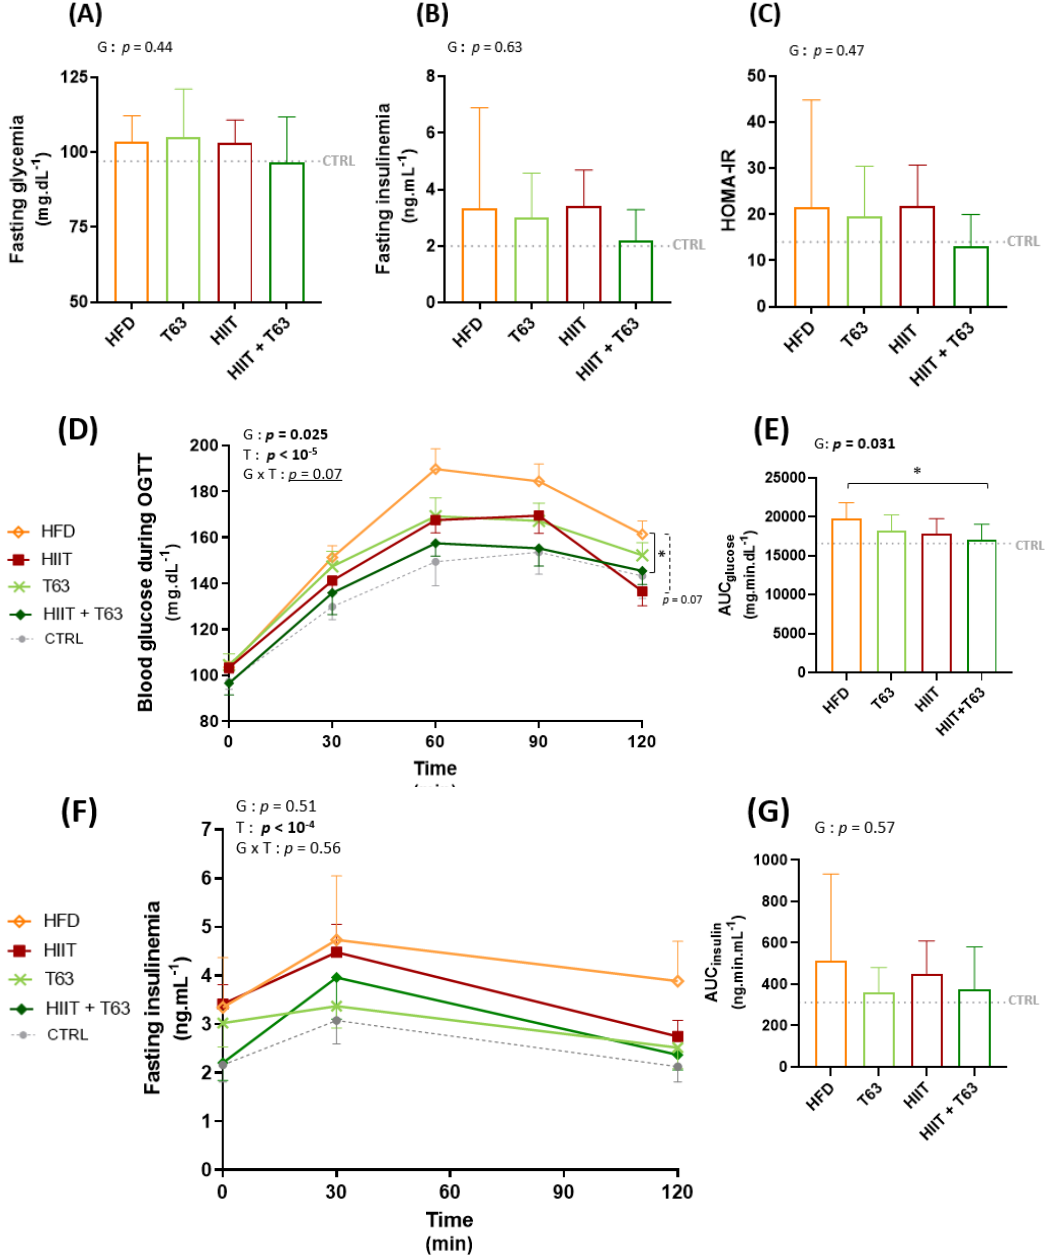
Figure 4. Effects of T63 supplementation and/or HIIT on (i) Fasting glycemia ( A ), Fasting insulinemia ( B ), and HOMA-IR ( C ) and on (ii) blood glucose ( D , E ), and insulin ( F , G ) levels during the oral glucose tolerance test (OGTT). * p < 0.05. AUC: area under the curve, G: group effect, T: time effect, G × T: group × time effect.